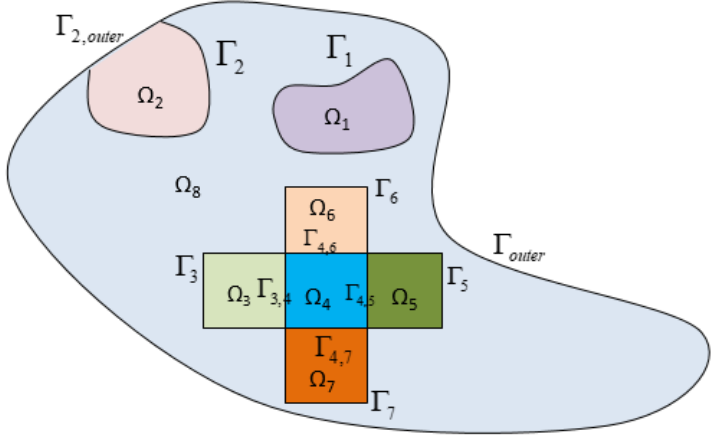
Figure 1. Schematic of the exemplified heterogeneous reservoir with eight regions.